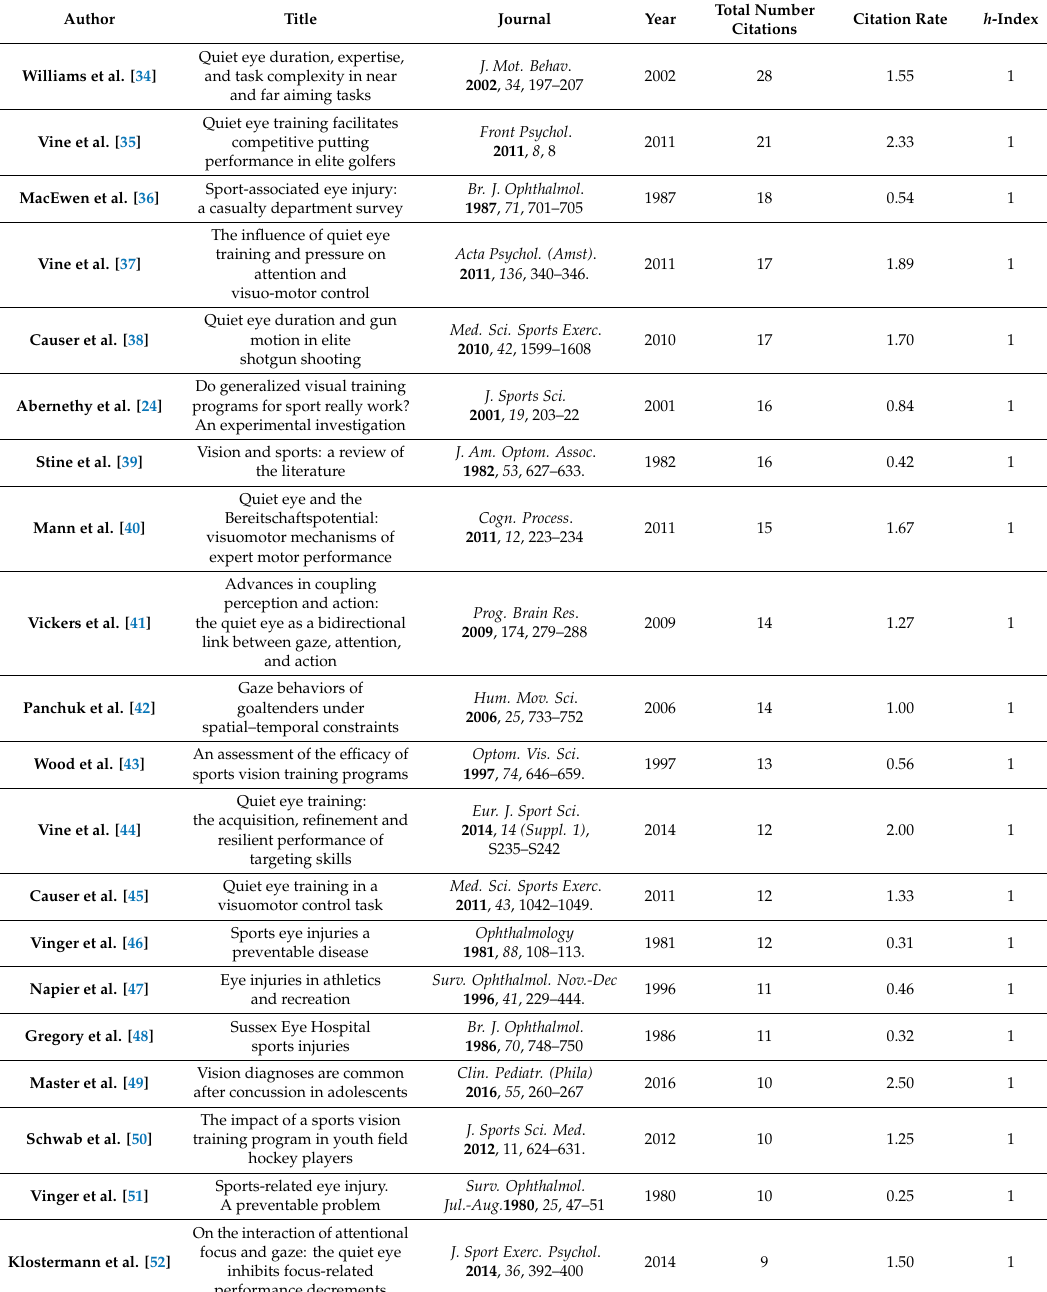
Table 1. Description of the 20 most cited publications on sports